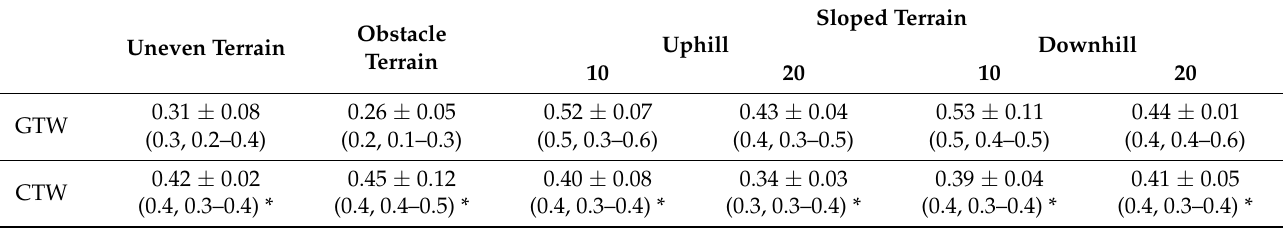
Table 10. Cronbach’s Alpha internal agreement between satisfaction items.